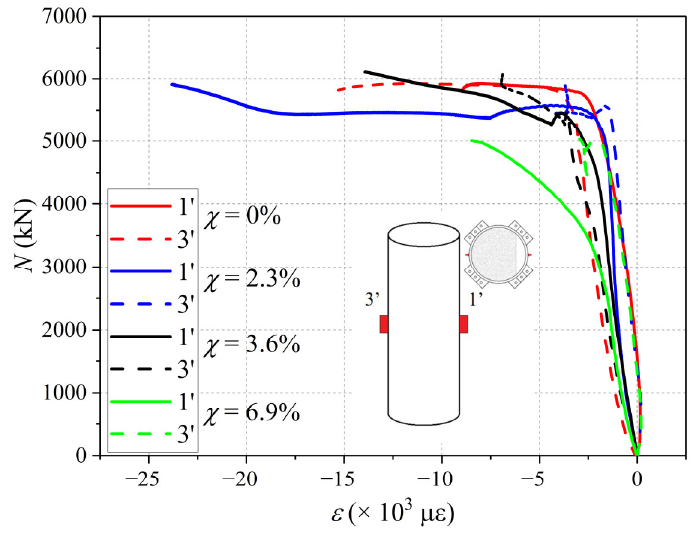
Figure 17. The N- ε l curves of cross-section at a 1/2 height of the BWCFST specimens with spherical-cap gap with different χ .